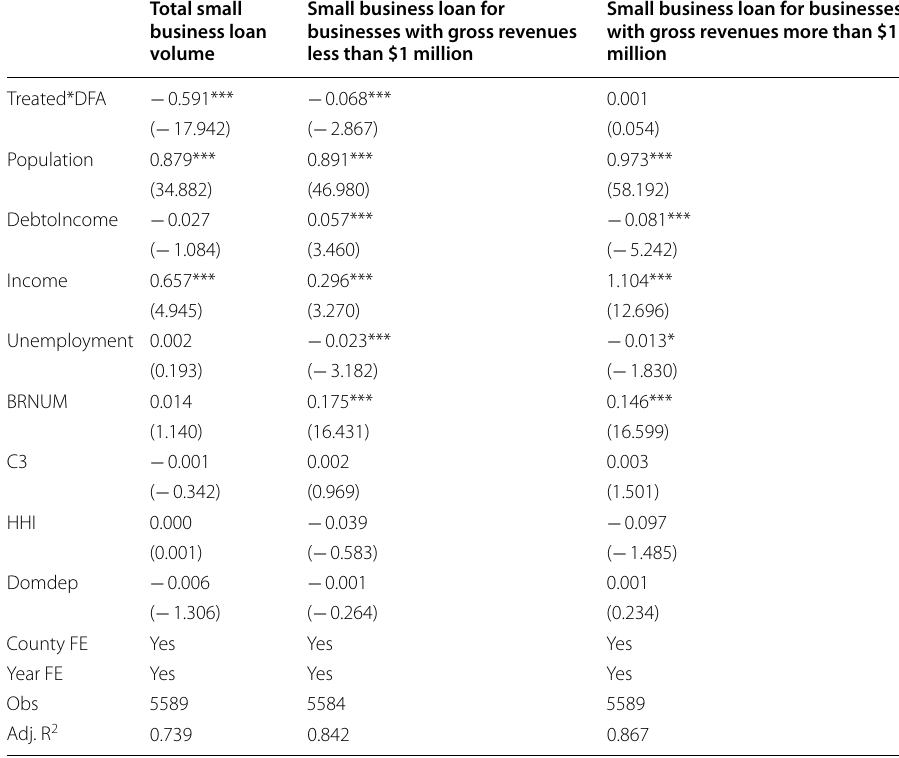
Table 9 Robustness results for county level